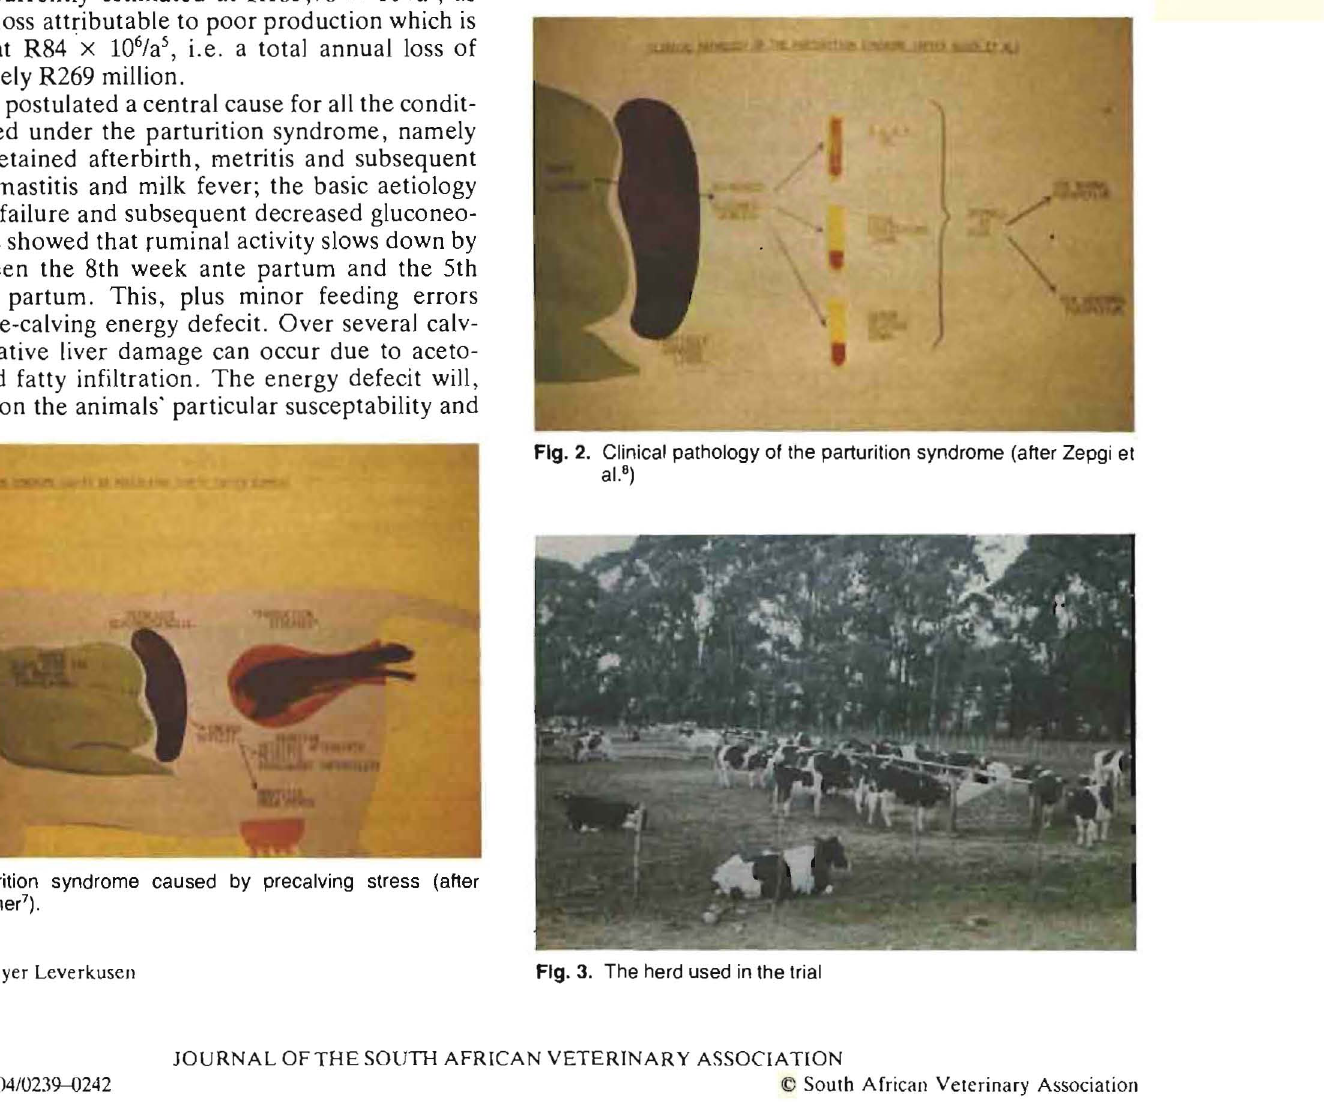
Fig. 3. The herd used in the